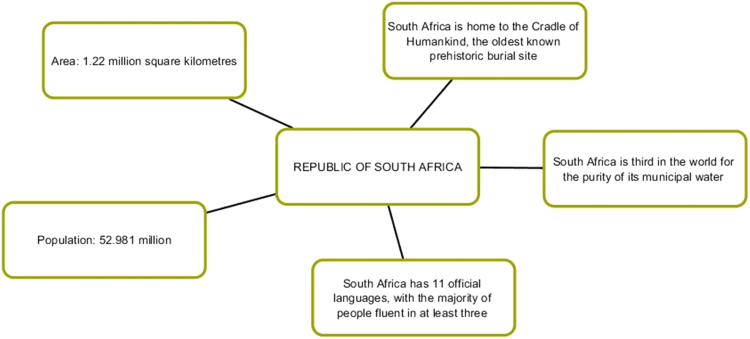
Infographics “Republic of South Africa” [1].